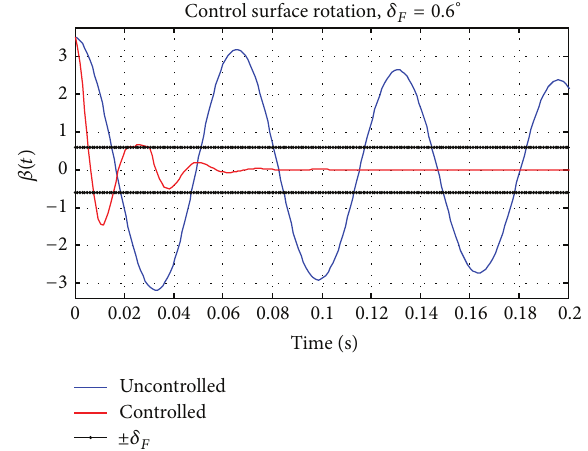
Figure 15: Case 2: control surface rotation ( |𝛿| = 0.4 ∘ and 𝑉 = 13.1 m/s).